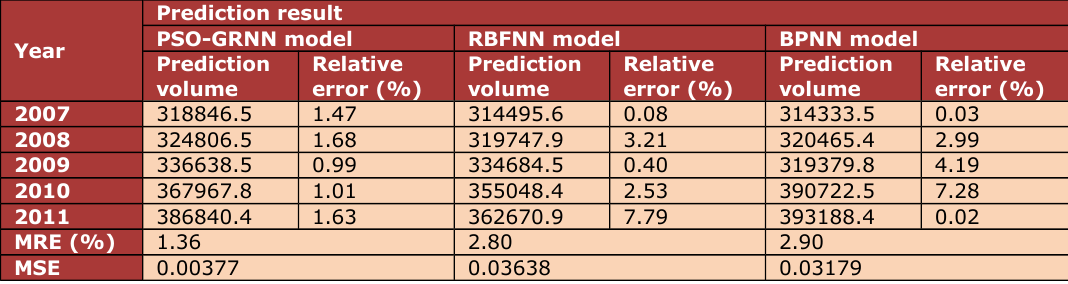
Table 4. Railway freight volume prediction